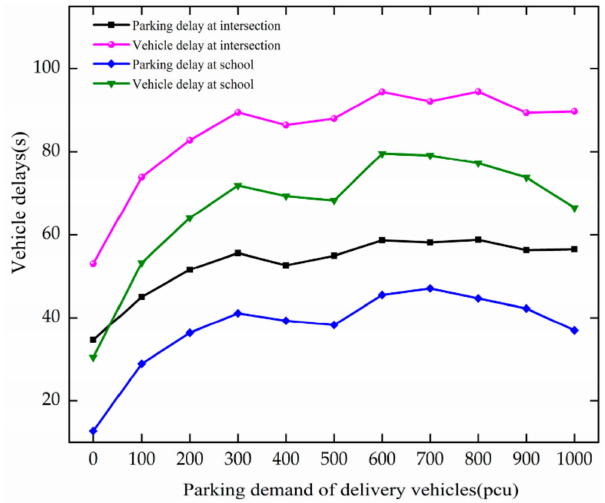
Figure 12. Variation trend of vehicle delay with